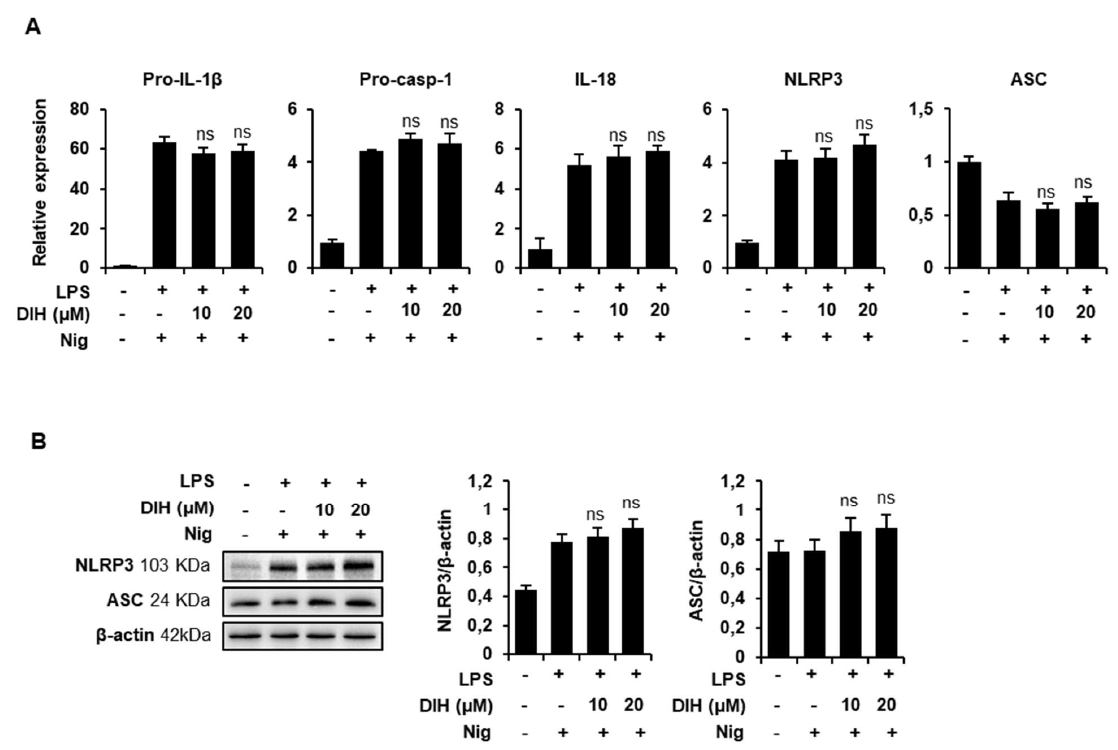
Figure 5. DIH has no effects on NLRP3 inflammasome components. J774A.1 macrophages were primed with LPS (1 μg/mL), then treated with DIH (10, 20 μM) and then stimulated with Nig (20 μM, 1 h). ( A ) Fold change of mRNA levels of inflammasome complex components. Results are expressed as means ± SD (n = 3). ( B ) Cell lysates after treatments were determined by immunoblot analysis of NLRP3 (103 kDa) and ASC (24 kDa) expression. β-actin was immunoblotted as a loading control. Densitometry analysis shows the mean ± SD of the western blot experiments. ns = not significant vs. LPS + Nig treatment.